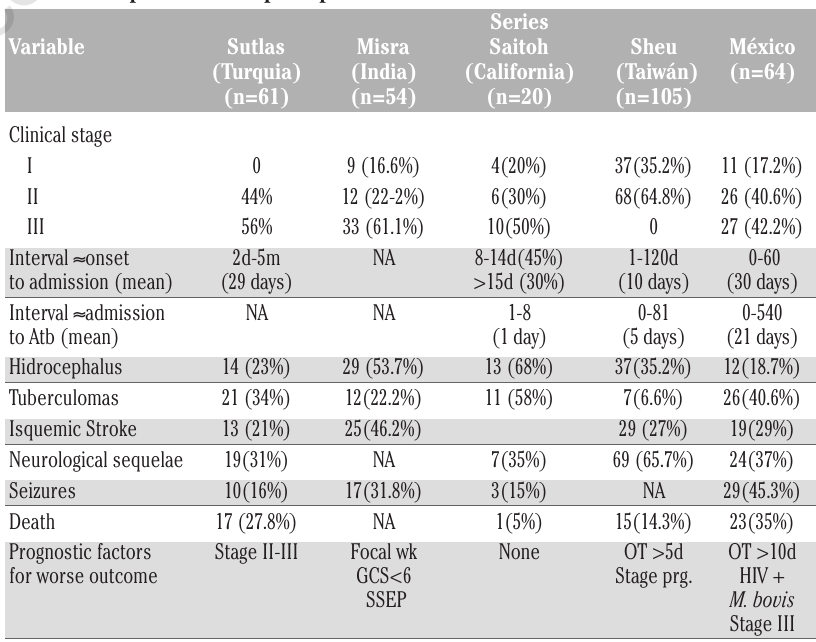
Table 2. Comparison of the principal characteristics between similar